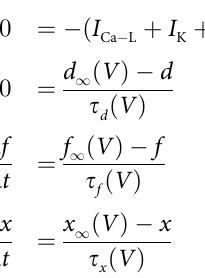
Fig 6. Two views of the EAD-containing voltage trace from Fig 3b superimposed on the critical manifold in ( f , x , V ) phase space. ( a ) ( x , V )-dominant view. ( b ) ( f , V )-dominant view. The superimposed solution (black) is comprised of: 1) a fast upstroke (cyan double arrows) caused by a stimulus pulse applied at rest (stable equilibrium E 1 ), 2) slow evolution (single arrow) along the upper attracting sheet of the critical manifold, S a ; þ 3) oscillatory EADs (unfilled arrows) near the fold curve, L (green), 4) fast transition (double arrows) toward the lower attracting sheet, S a ; (cid:0) (single arrow) to E 1 along S a ; (cid:0) . The folded node singularity ( FN , purple marker), a pseudo-equilibrium of the slow subsystem, lies within L ; its associated singular 0 strong canard, g 0 (magenta), a special solution of the slow subsystem, together with L , bounds the region of solutions of the slow subsystem, that are funneled 0 through the folded node. Parameter values: Δ V 1/2 ( d 1 ) = - Δ V 1/2 ( f 1 ) = -2.08 mV.